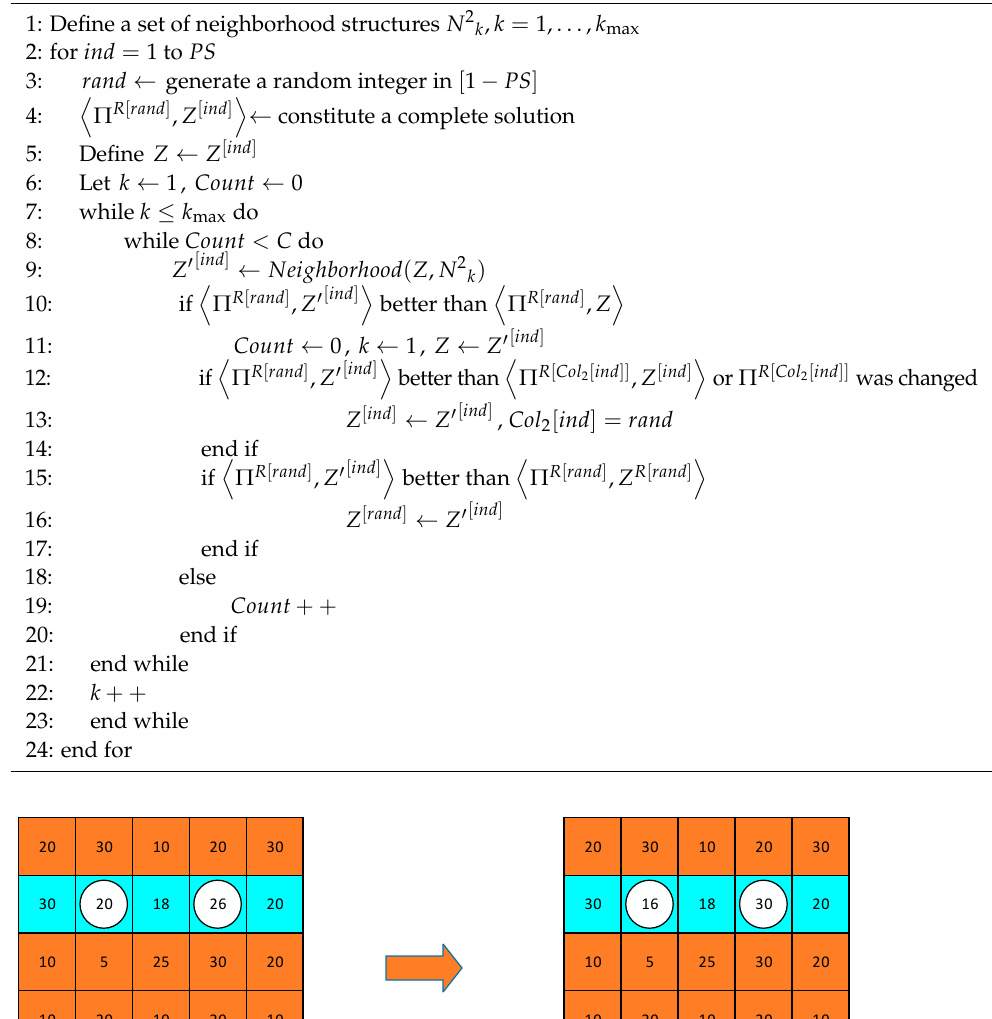
Algorithm 2 Evolution of the lot split population